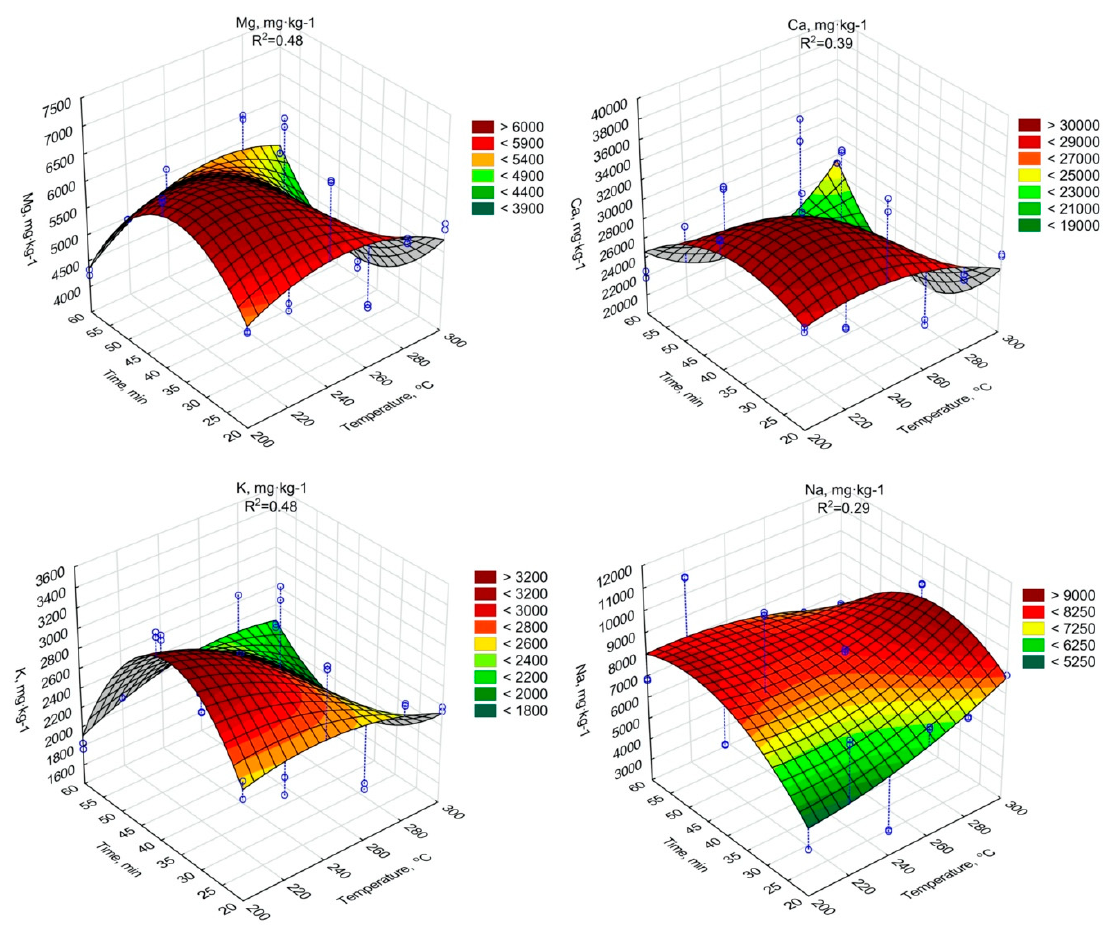
Figure 5. Mg, Ca, K, Na content in torrefied SS in relation to process residence time and temperature.